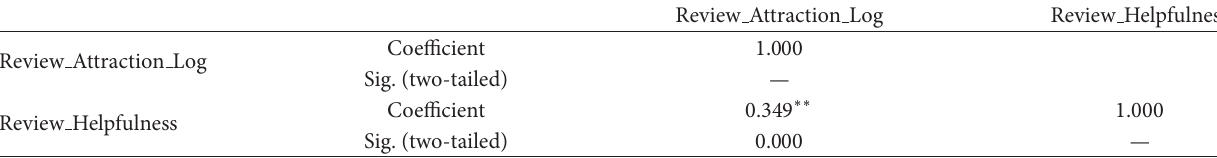
Table 7: Correlation between review attraction and review helpfulness.